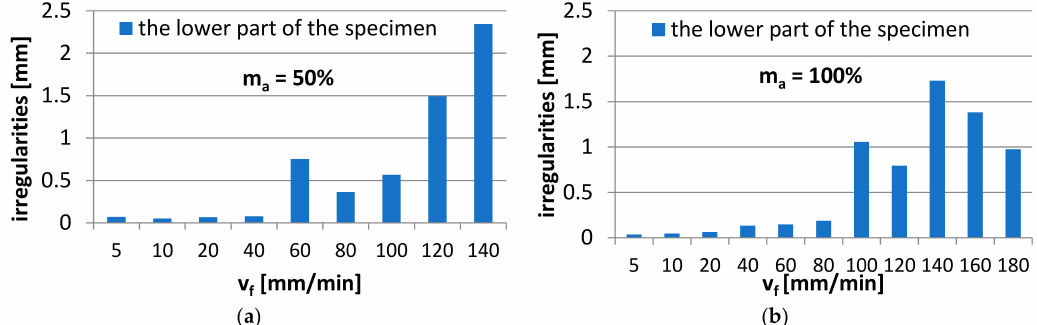
Figure 5. Irregularities in the examined region of the lower part of the specimen for the abrasive material flow rate: ( a ) 50% and ( b ) 100%.